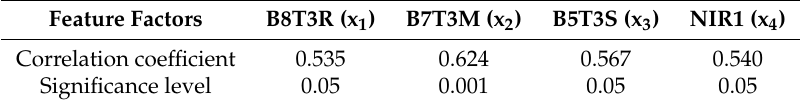
Table 4. Correlation between feature factors and spatial structural